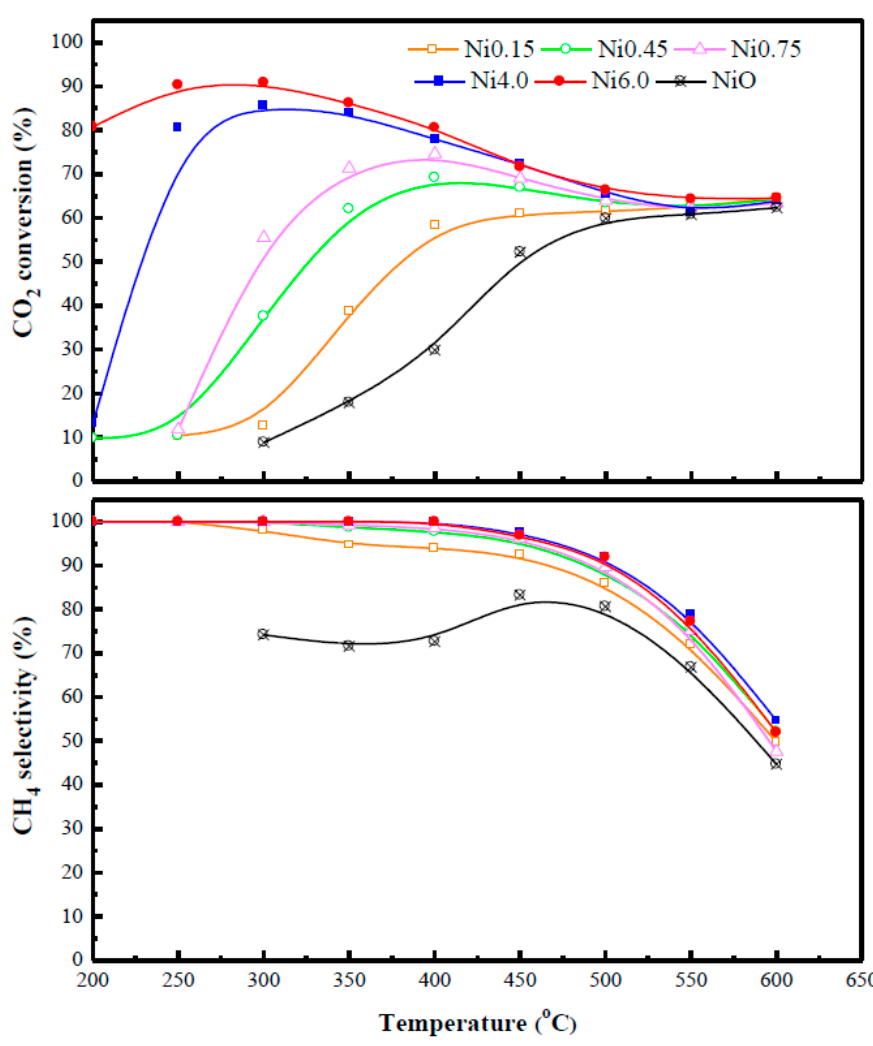
Figure 5. CO 2 conversion and CH 4 selectivity of Ni-Ce-ZrO δ catalysts for the methanation of CO 2 . Table 2. Summary of the reaction results of CO 2 methanation.